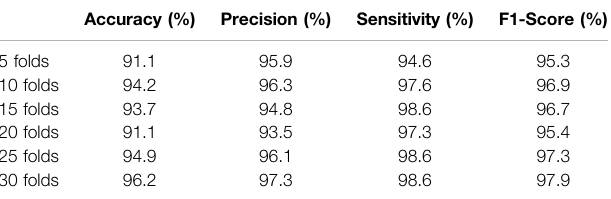
TABLE 3 | Performance of DT classi fi